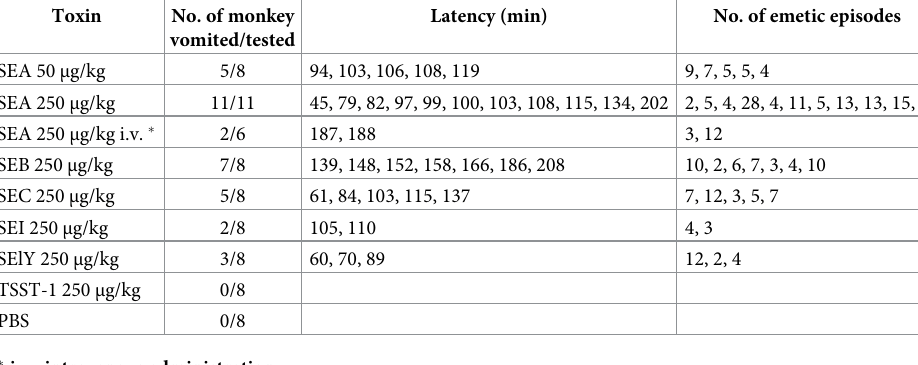
Table 1. Emetic response induced by SEs in common